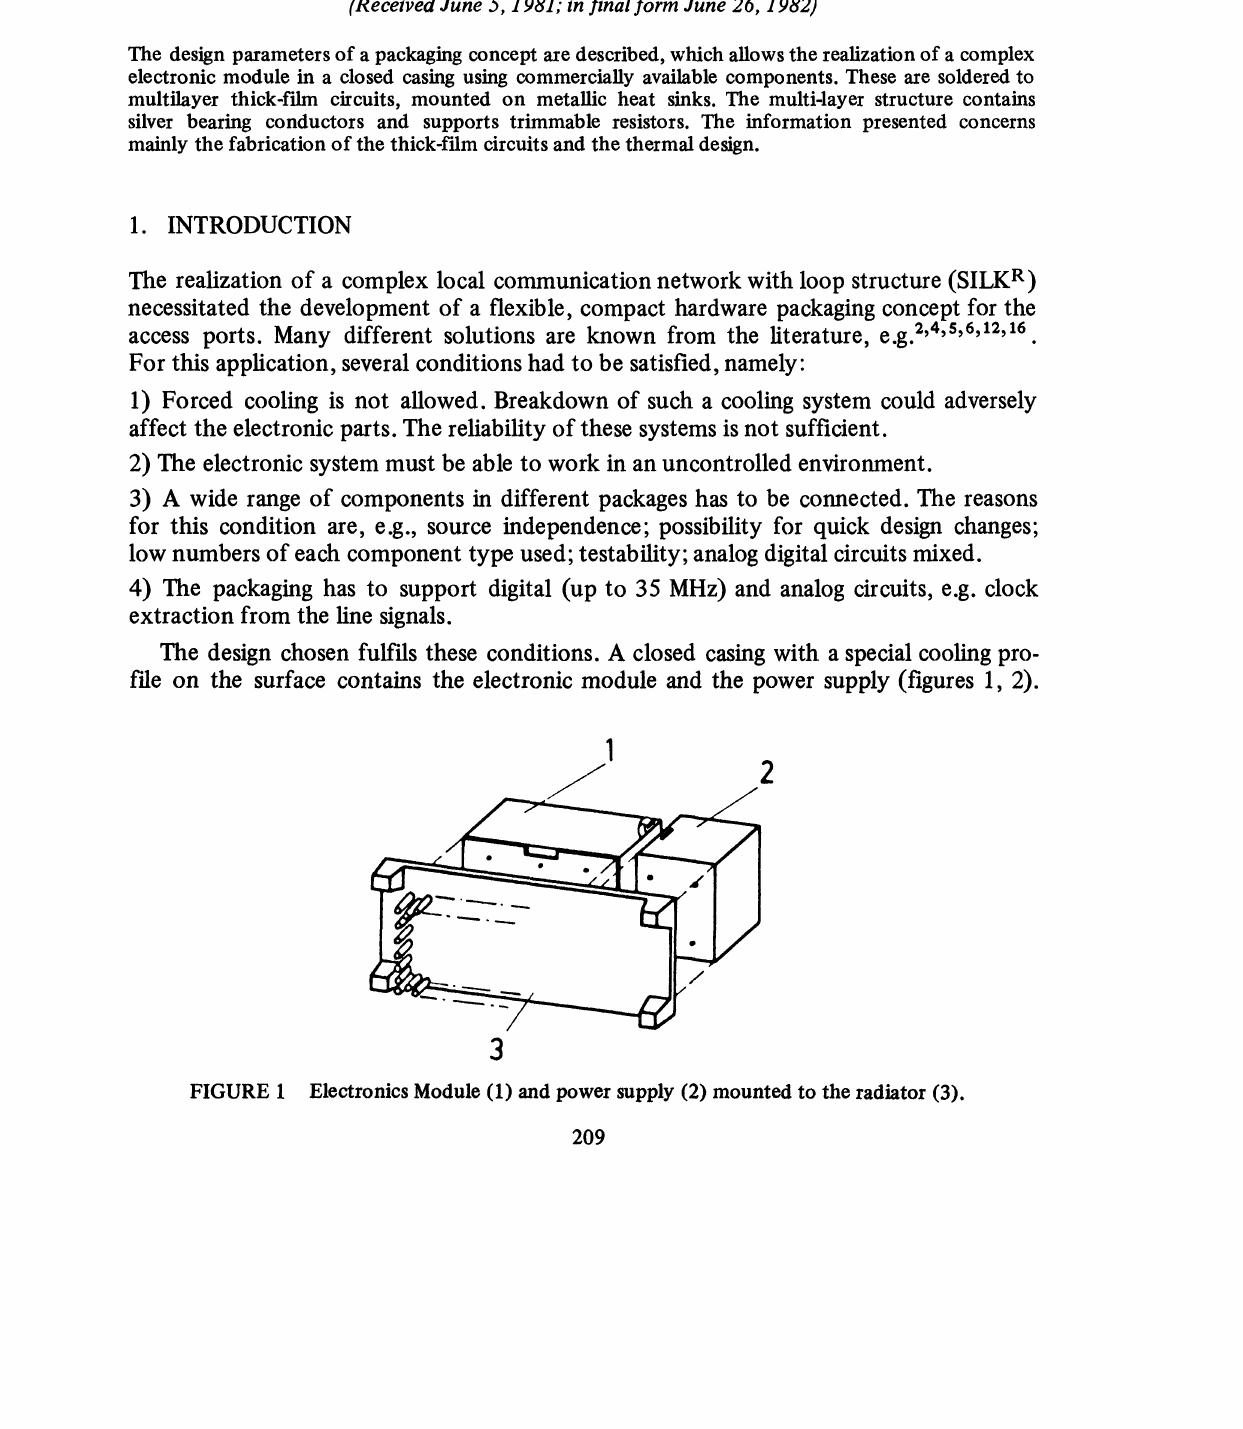
FIGURE 1 Electronics Module (1) and power supply (2) mounted to the radiator (3).